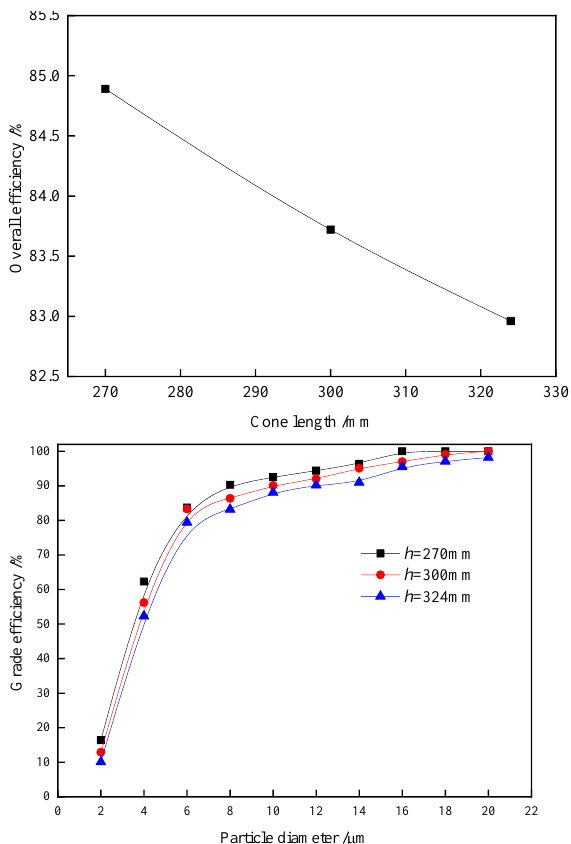
Figure 15. The overall efficiency and grade efficiency for different cone lengths. However, as the turbulence intensity at the bottom of the cone decreases, the flow resistance decreases, which reduces the number of particle collisions on the wall and particle velocity. Figure 16 shows the comparison of the erosion of the cone under three different cone lengths; the erosion rate of the cone is significantly reduced, but the maximum erosion rate is a small reduction, as shown in Figure 17. Therefore, it is difficult to achieve the goals of reducing wall erosion and keeping separation efficiency at the same time by changing the size of the cyclone cone.